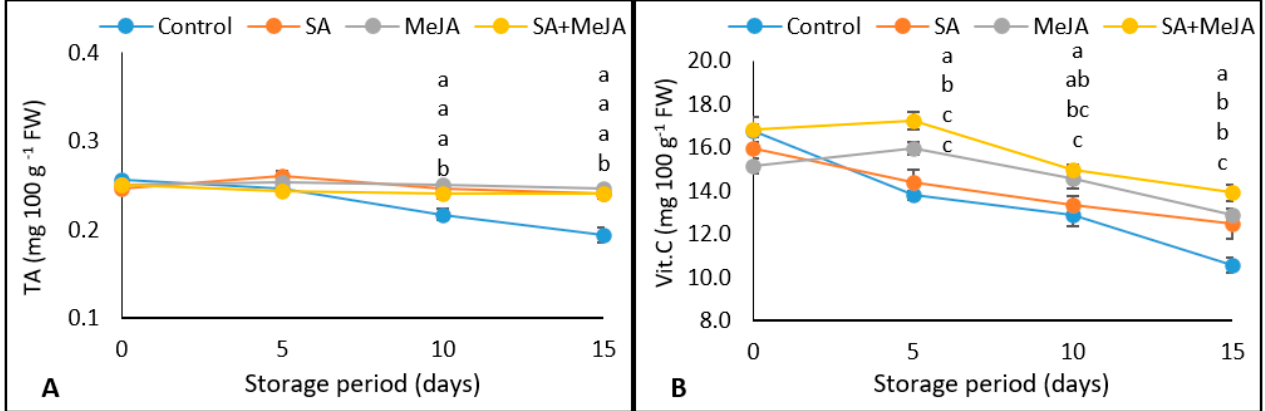
Figure 4. Effects of salicylic acid (SA), methyl jasmonate (MeJA), or their combination postharvest treatments on ( A ) titratable acidity (TA) and ( B ) vitamin C of pomegranate arils stored at 5 °C for 15 days. The presented data are the mean of three replicates ± standard error. Different letters present significant differences between treatments at the same storage point according to the Duncan test at p < 0.05.